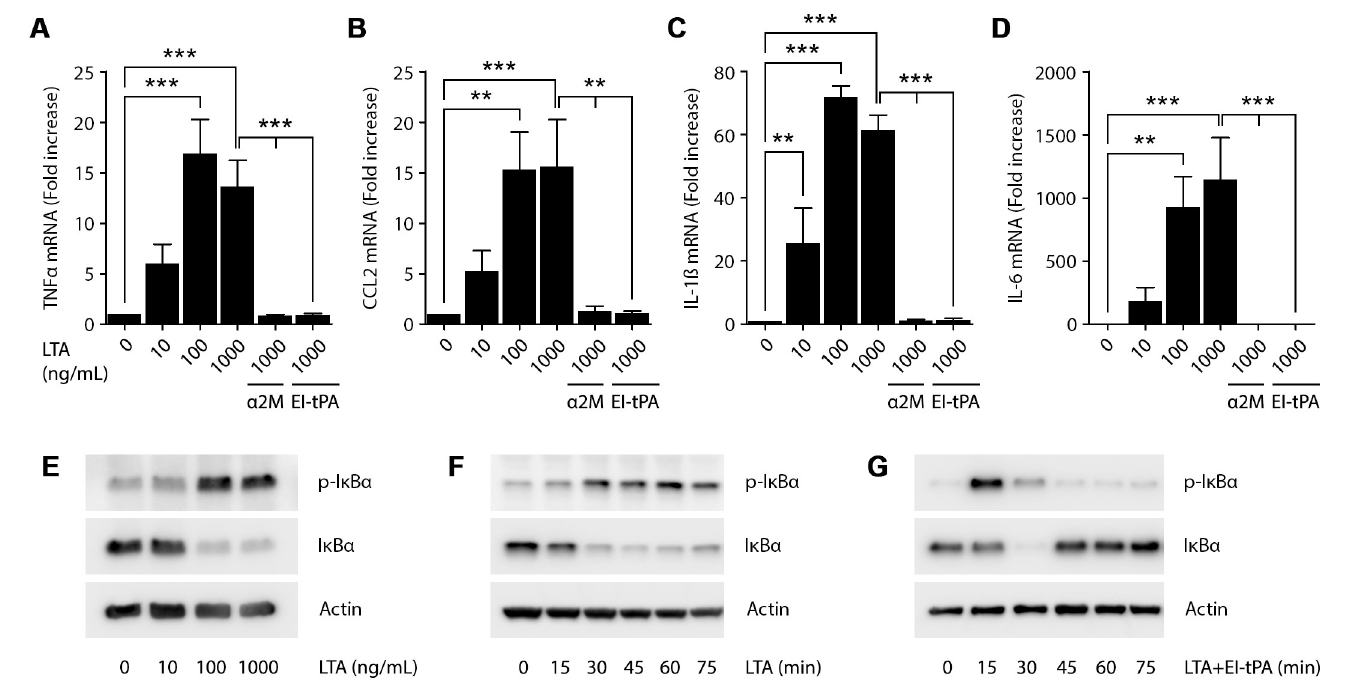
Fig 1. EI-tPA blocks TLR2-induced inflammatory response in BMDMs. BMDMs were treated with increasing concentrations of the TLR2 agonist, LTA (0.01–1 μ g/ mL), or with LTA (1 μ g/mL) plus activated α 2M (10 nM) or EI-tPA (12 nM) for 6 h. RT-qPCR was performed to compare mRNA levels of (A) TNF α , (B) CCL2, (C) IL-1 β , and (D) IL-6 (mean ± SEM; n = 4–5; one-way ANOVA with Bonferroni post-hoc test on selected pairs of columns; �� p < 0.01, ��� p < 0.001). Immunoblot analysis showing total and phosphorylated I κ B α in BMDMs treated with: (E) increasing concentrations of LTA (0.01–1 μ g/mL) for 1 h; (F) 1 μ g/mL LTA for the indicated times; and (G) 1 μ g/mL LTA plus 12 nM EI-tPA for the indicated times. β -actin levels are shown as a